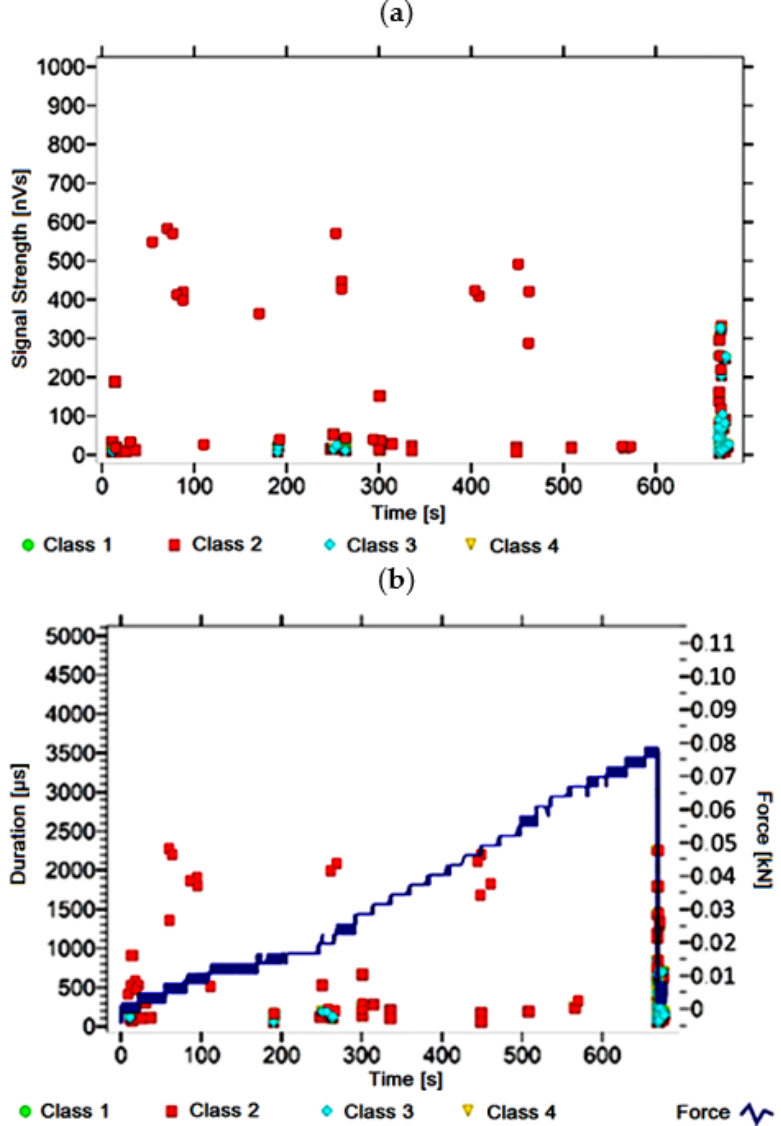
Figure 15. Graphs of acoustic emission signals for an exemplary sample of A 14 series: ( a ) signal strength over time; ( b ) distribution of the duration of the signals over time with the force increment curve.